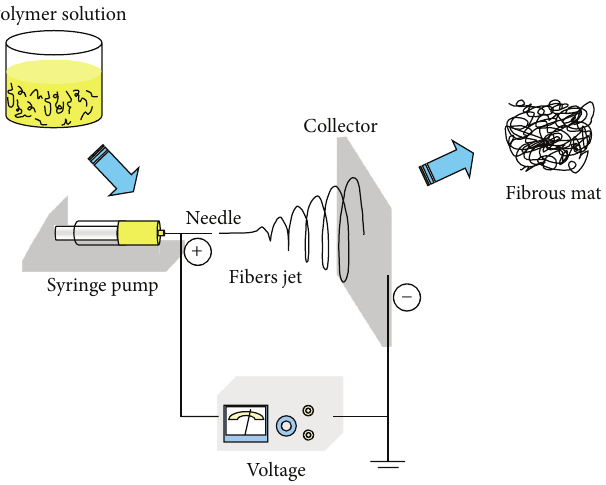
Figure 1: Schematic illustration of the electrospinning